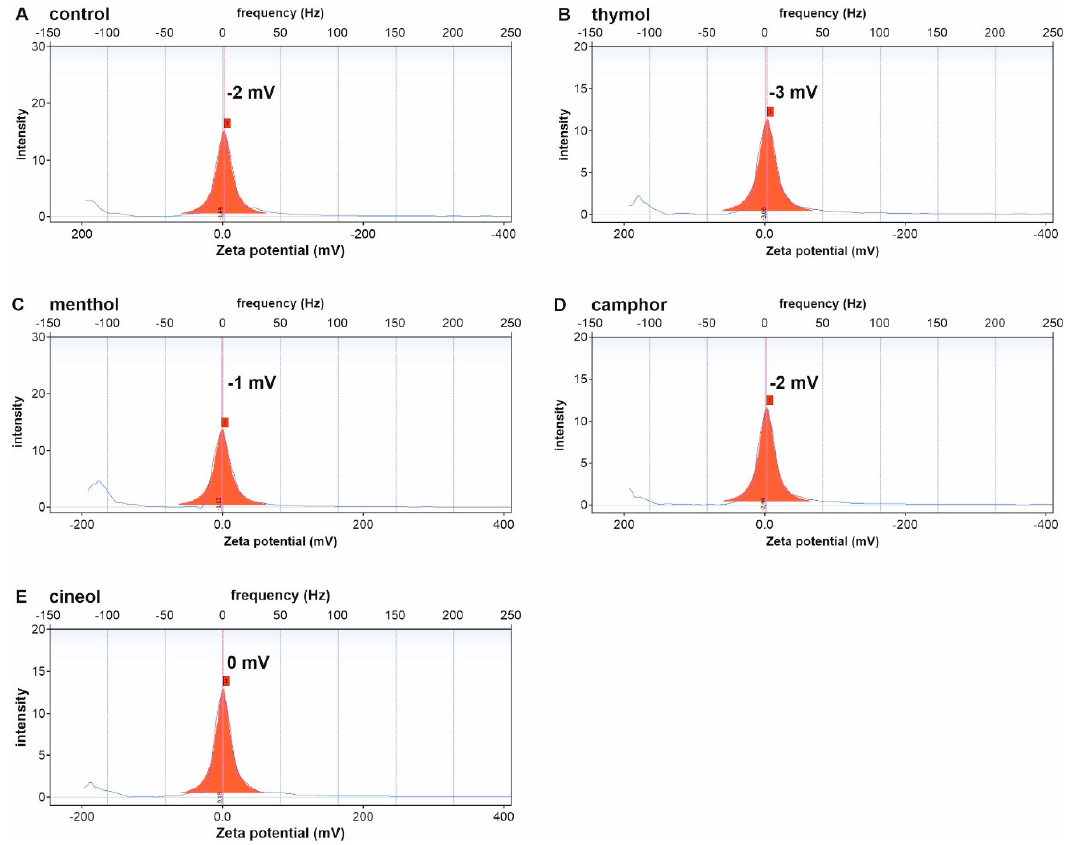
Figure 3. Invasomes without tepenoids ( A ) and encapsulating the terpenoids thymol ( B ) menthol ( C ) camphor ( D ) or cineol ( E ) reveal neutral Zeta potentials.